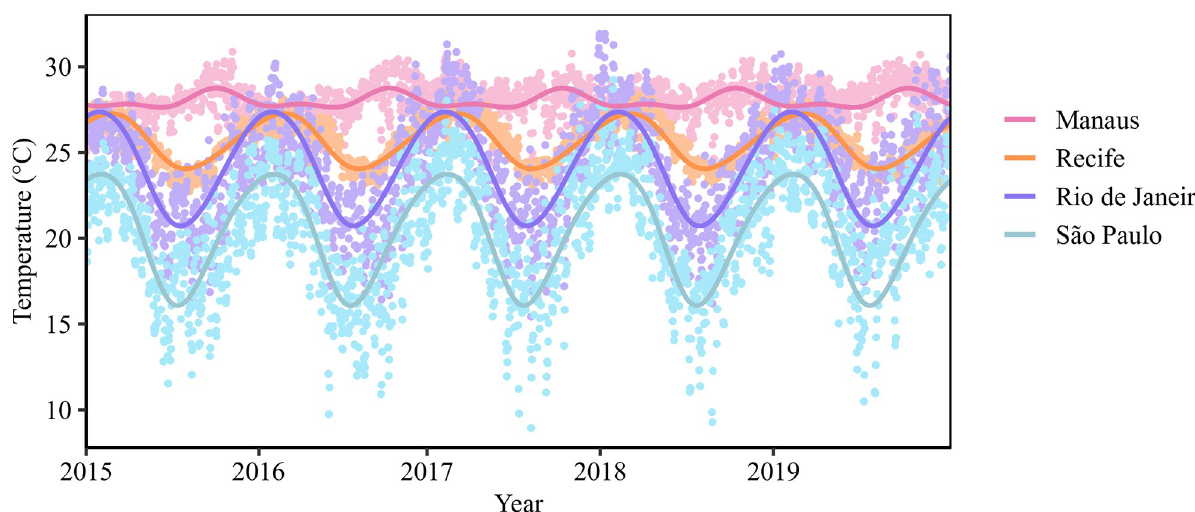
Fig 1. Daily temperature in 4 Brazilian cities, 2015–2019. Periodic cubic spline models are fit to the data for Manaus, Recife, Rio de Janeiro, and S ã o Paulo to develop mean seasonal temperature models.